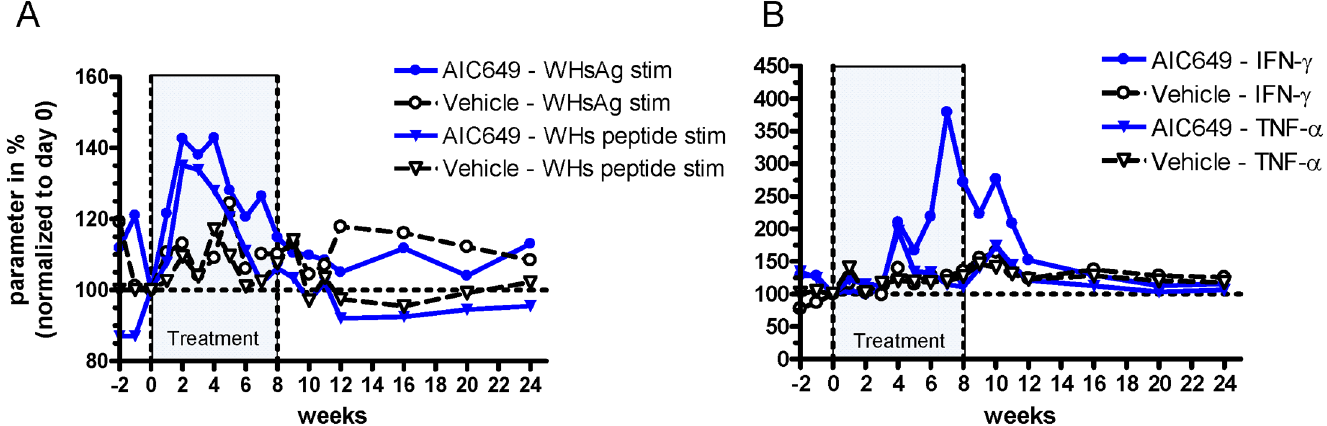
Fig 5. AIC649 treatment induces cell-mediated immune responses in chronic WHV carrier woodchucks. AIC649 (3.9 x 10 6 Units (ELISA-based titer)) or vehicle were administered i.m. twice weekly for 8 weeks (marked “ Treatment ” ). At the indicated time points woodchucks were bled and PBMCs were subjected to determination of T cell proliferation after stimulation, whereas whole blood was used to analyze transcript levels of cytokines. Values were normalized to individual baseline at day 0 and are given in %. n = 5 / group. Dotted lines: 100% level. (A) Percent-change in mean T cell proliferation level from baseline at day 0 for woodchucks in the vehicle and AIC649 groups, respectively, following stimulation of PBMCs with WHsAg (WHsAg stim) or WHs peptide S226-245 (WHs peptide stim). (B) Percent-change in mean IFN- γ and TNF- α transcript level from baseline at day 0 in blood of woodchucks from both groups.